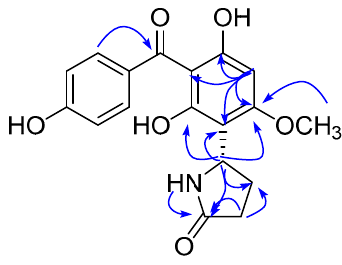
Figure 2. Key HMBC correlations of compound 1 . Table 1. 1 H NMR and 13 C NMR spectroscopic data for compound 1 (DMSO- d 6 ).